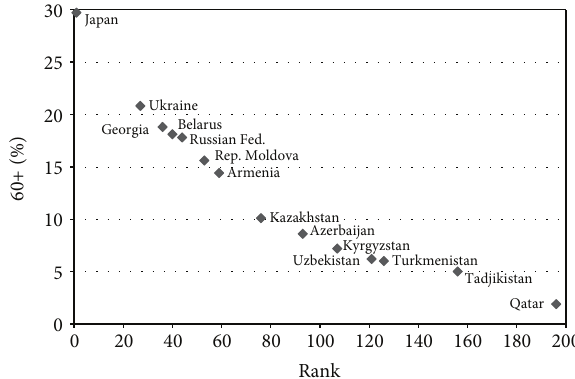
F 1: Ranking CIS countries by percentage of population aged 60+, 2009 (source: